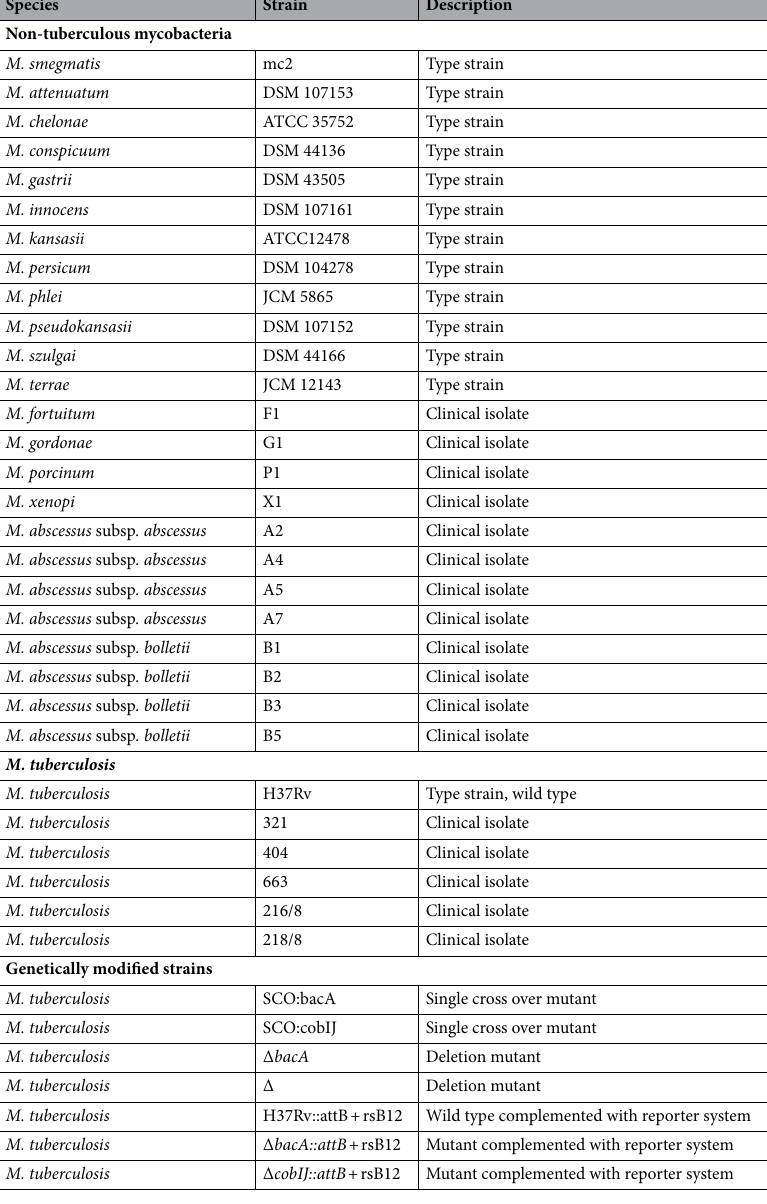
Table 4. List of strains used in this